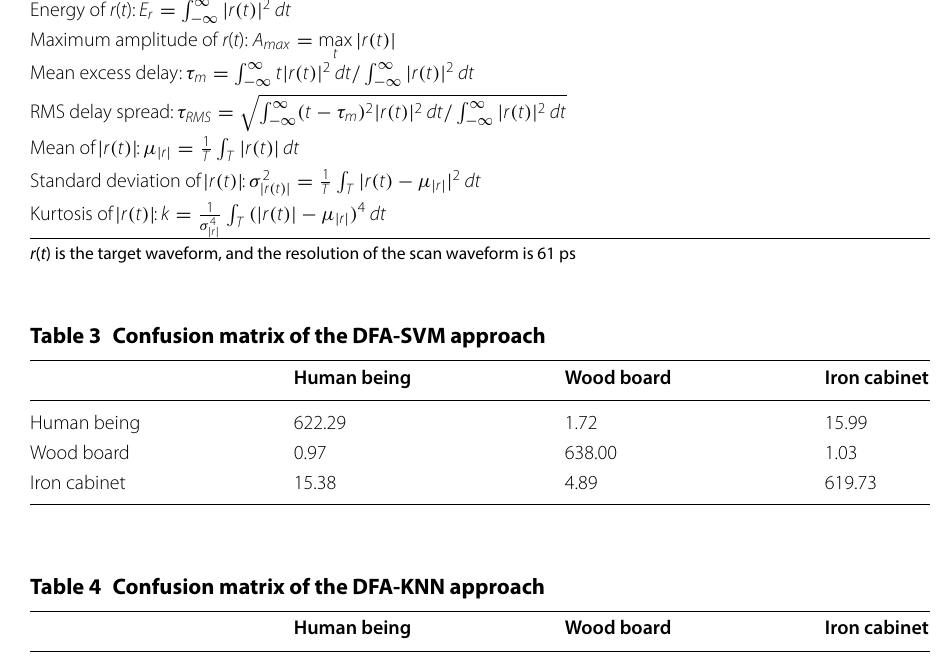
∞ | r ( t ) | 2 dt −∞ (cid:31)